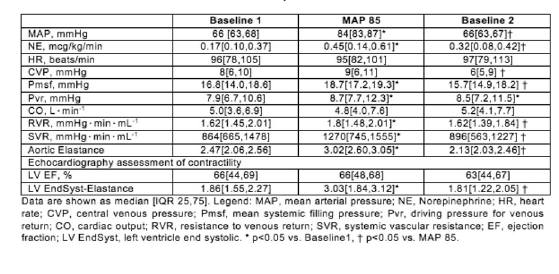
Table 1 (abstract 001078). Hemodynamics variables